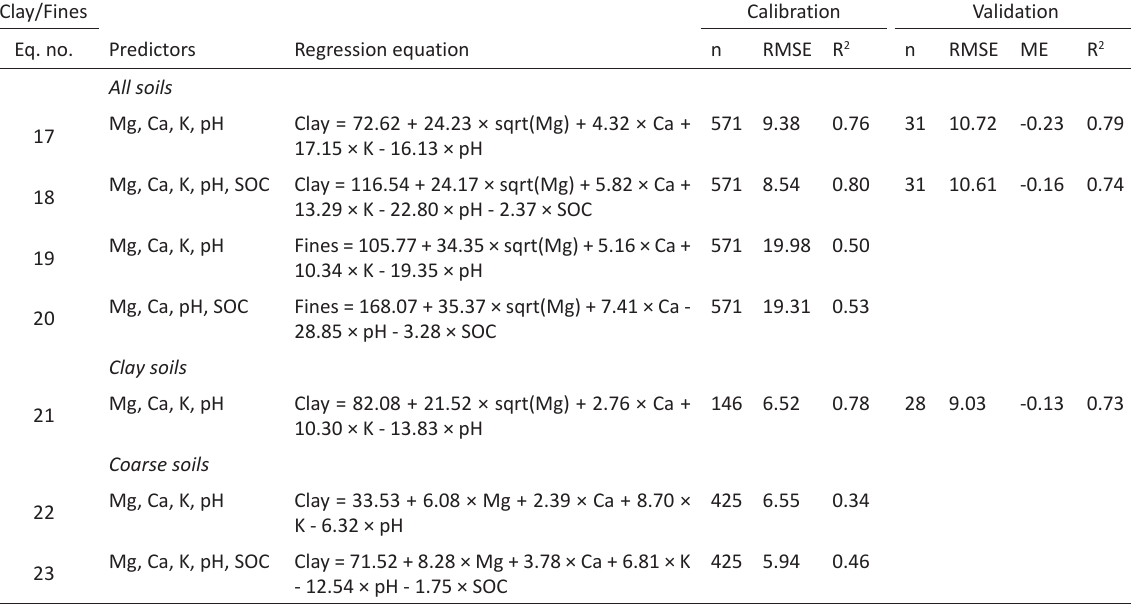
Table 9. Pedotransfer functions for estimating mineral soil clay content (%) and FINES content (%, fine-sized particles; ∅ < 0.02 mm)